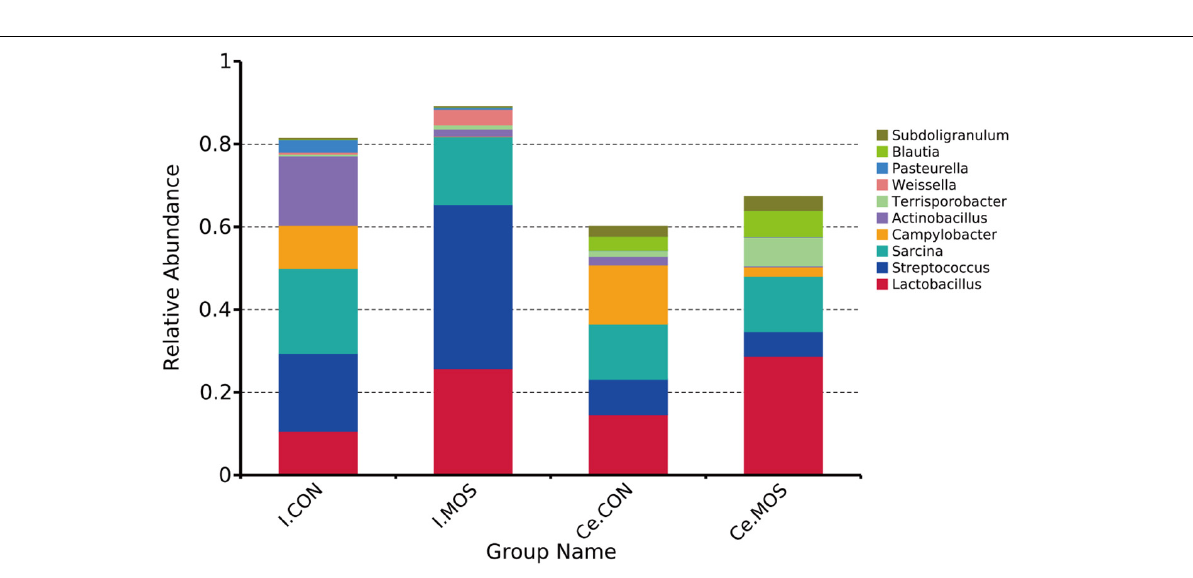
FIGURE 7 | Bar graph shows the genus-level composition of bacteria. Color-coded bar plot shows the relative abundance of bacterial phyla across the different groups. I.MOS means ileal digesta samples from pigs fed with a basal diet supplemented with 3 g/kg MOS; Ce.CON means cecal digesta samples from pigs fed with the basal diet; Ce.MOS means cecal digesta samples from pigs fed with a basal diet supplemented with 3 g/kg MOS. For 16S rRNA analysis, two digesta samples in each group were pooled ( n =